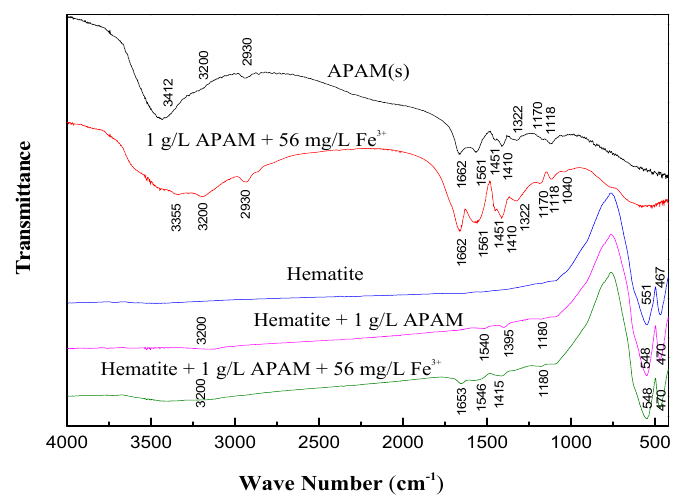
Figure 7. FTIR spectra of APAM and hematite-APAM in the presence of Fe 3+ .